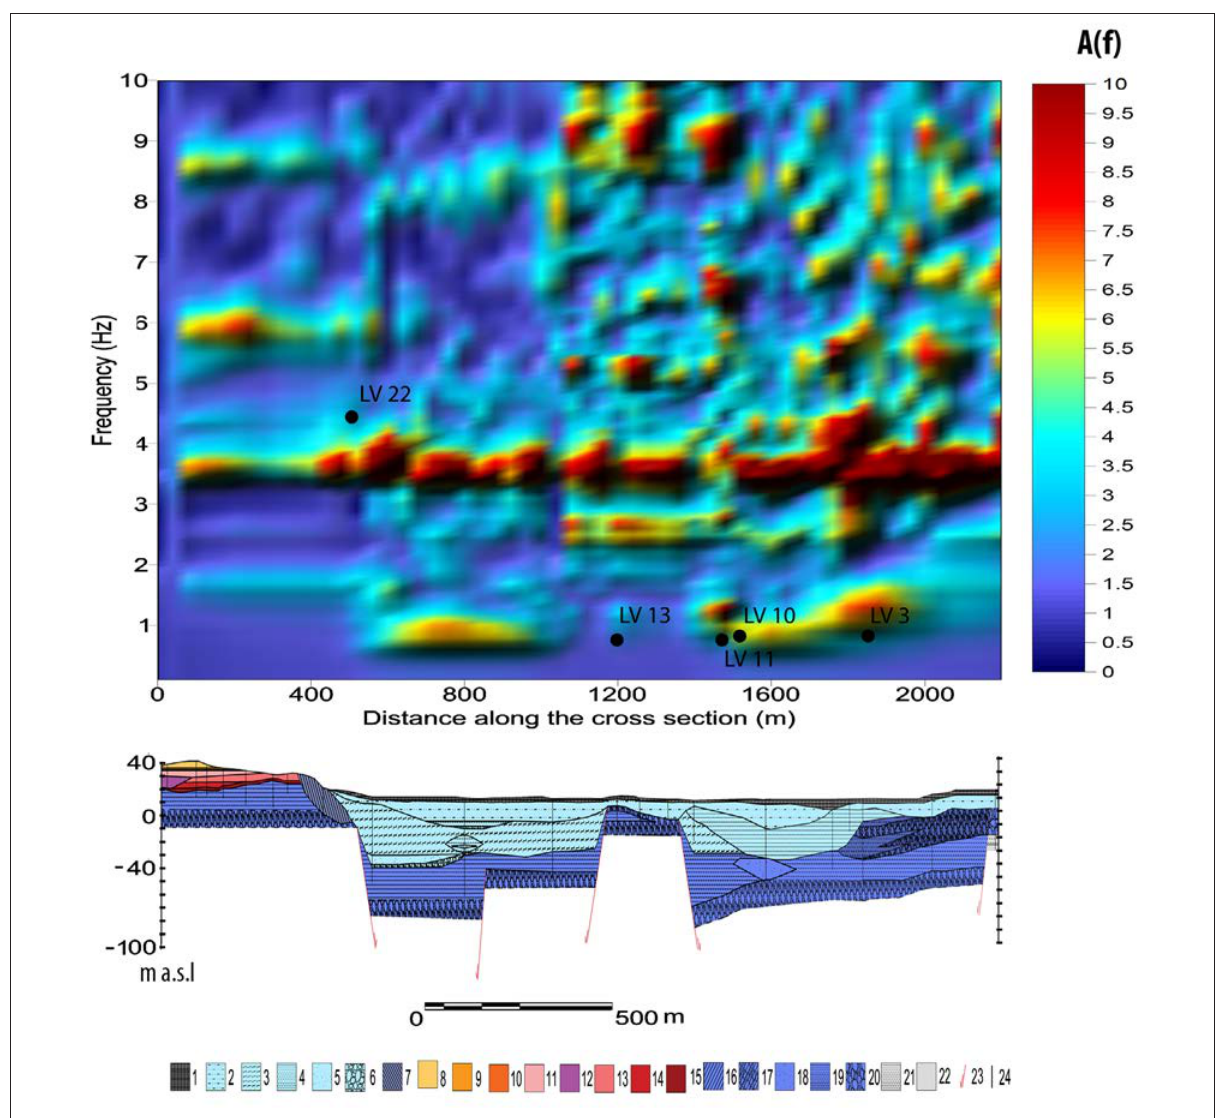
Figure 14. 2D A(f) distribution (top) along the ancient route of Via Laurentina (bottom). See Figure 4 for the key to the legend. Location of x noise measurements along the route (and related first H/V peak) is also